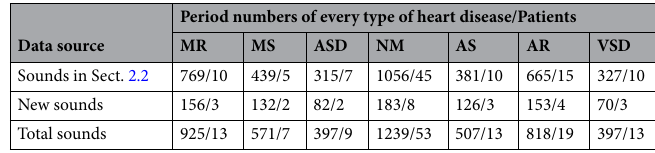
Table 5. Experimental sounds used to evaluate the performance.